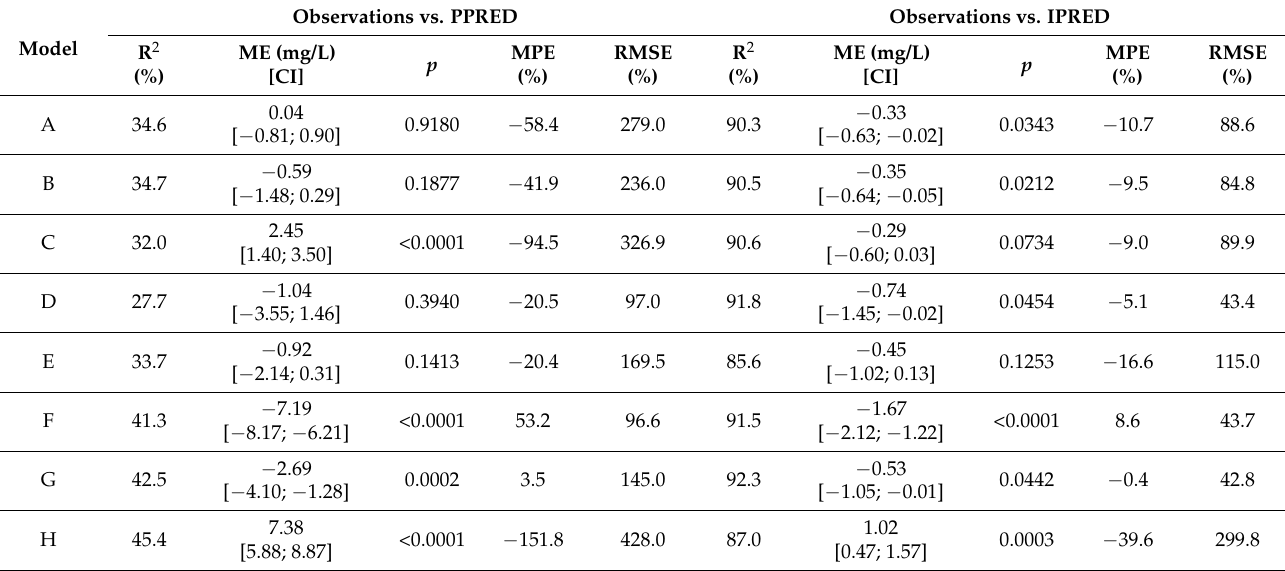
Table 3. Comparison of population predictions (PPRED) and individual predictions (IPRED) to observations for the 8 evaluated models.